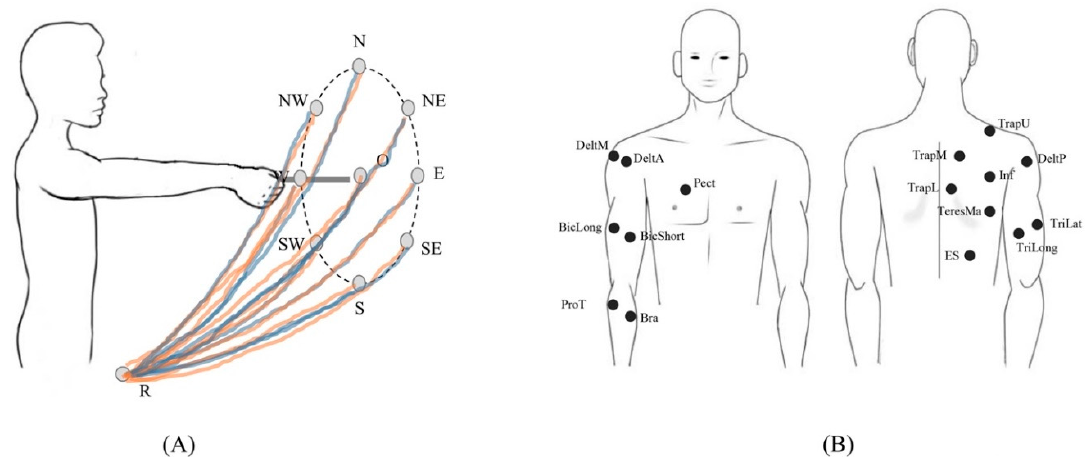
Figure 1. Experiment task ( A ) and positioning of EMG probes ( B ). Sixteen muscles were measured: Erector Spinae (ES), Teres Major (TeresMa), Infraspinatus (Inf), Lower Trapezius (TrapL), Middle Trapezius (TrapM), Upper Trapezius (TrapU), Deltoid Anterior (DeltA), Deltoid Middle (DeltM), Deltoid Posterior (DeltP), Pectoralis (Pect), Triceps Long Head (TriLong), Triceps Lateral Head (TriLat), Biceps Long Head (BicLong), Biceps Short Head (BicShort), Brachioradialis (Bra), and Pronator Teres (ProT).